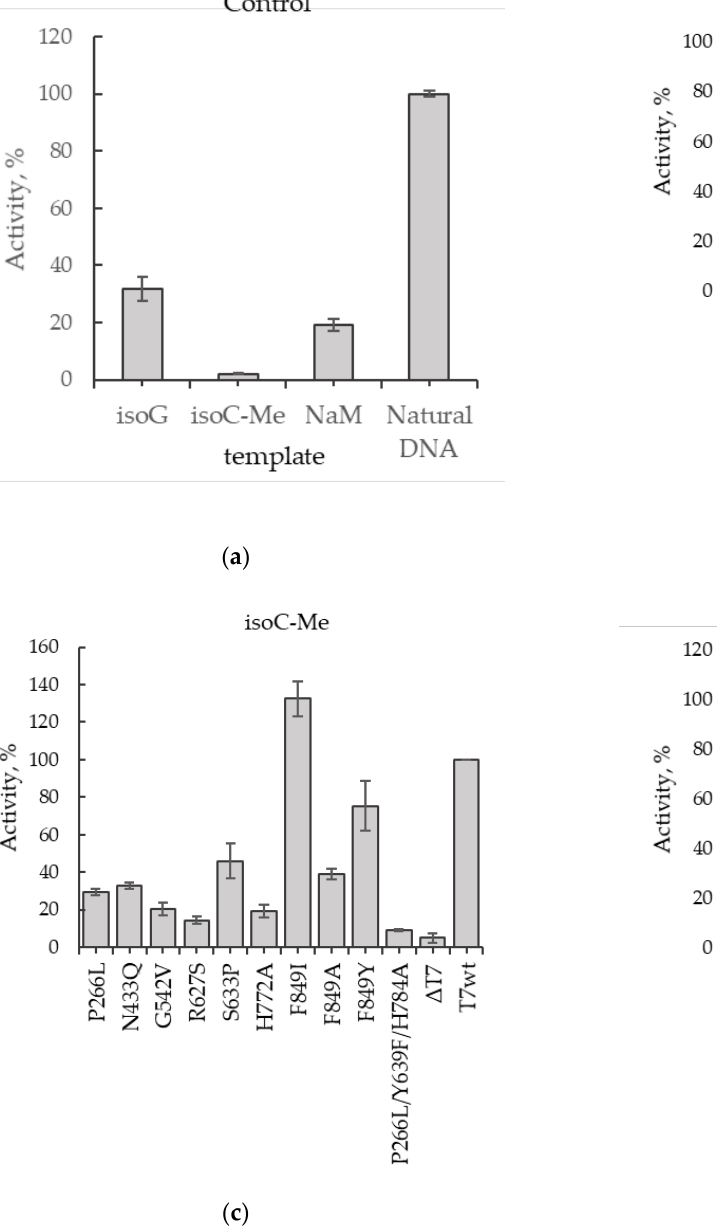
Figure 3. Activity of the T7 RNAP mutants on the templates containing unnatural nucleotides in the second position of V29 codon of Nluc normalized on the amount of T7 RNAP synthesized in the coupled 2 cell-free system, n = 3, mean ± SD. ( a ) Activity of T7 RNAP wt on different templates. ( b ) Activity of T7 RNAP mutants on the template containing isodG. ( c ) Activity of T7 RNAP mutants on the template containing 5-Me-isodC. ( d ) Activity of T7 RNAP mutants on the template containing dNaM.